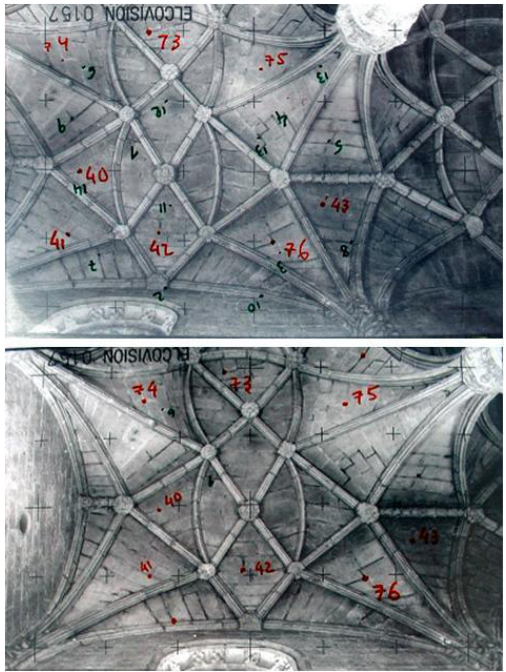
Figure 4. The nave vault of the church of Jerónimos monastery. A photogrammetric pair, with indication of the topographic control points (in red) (Genin, 1995).